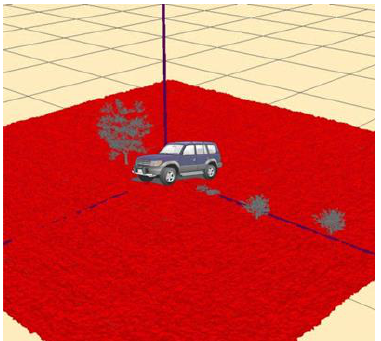
Fig. 1. Radar scene with a target. Fig. 2. A radar scene without a target.